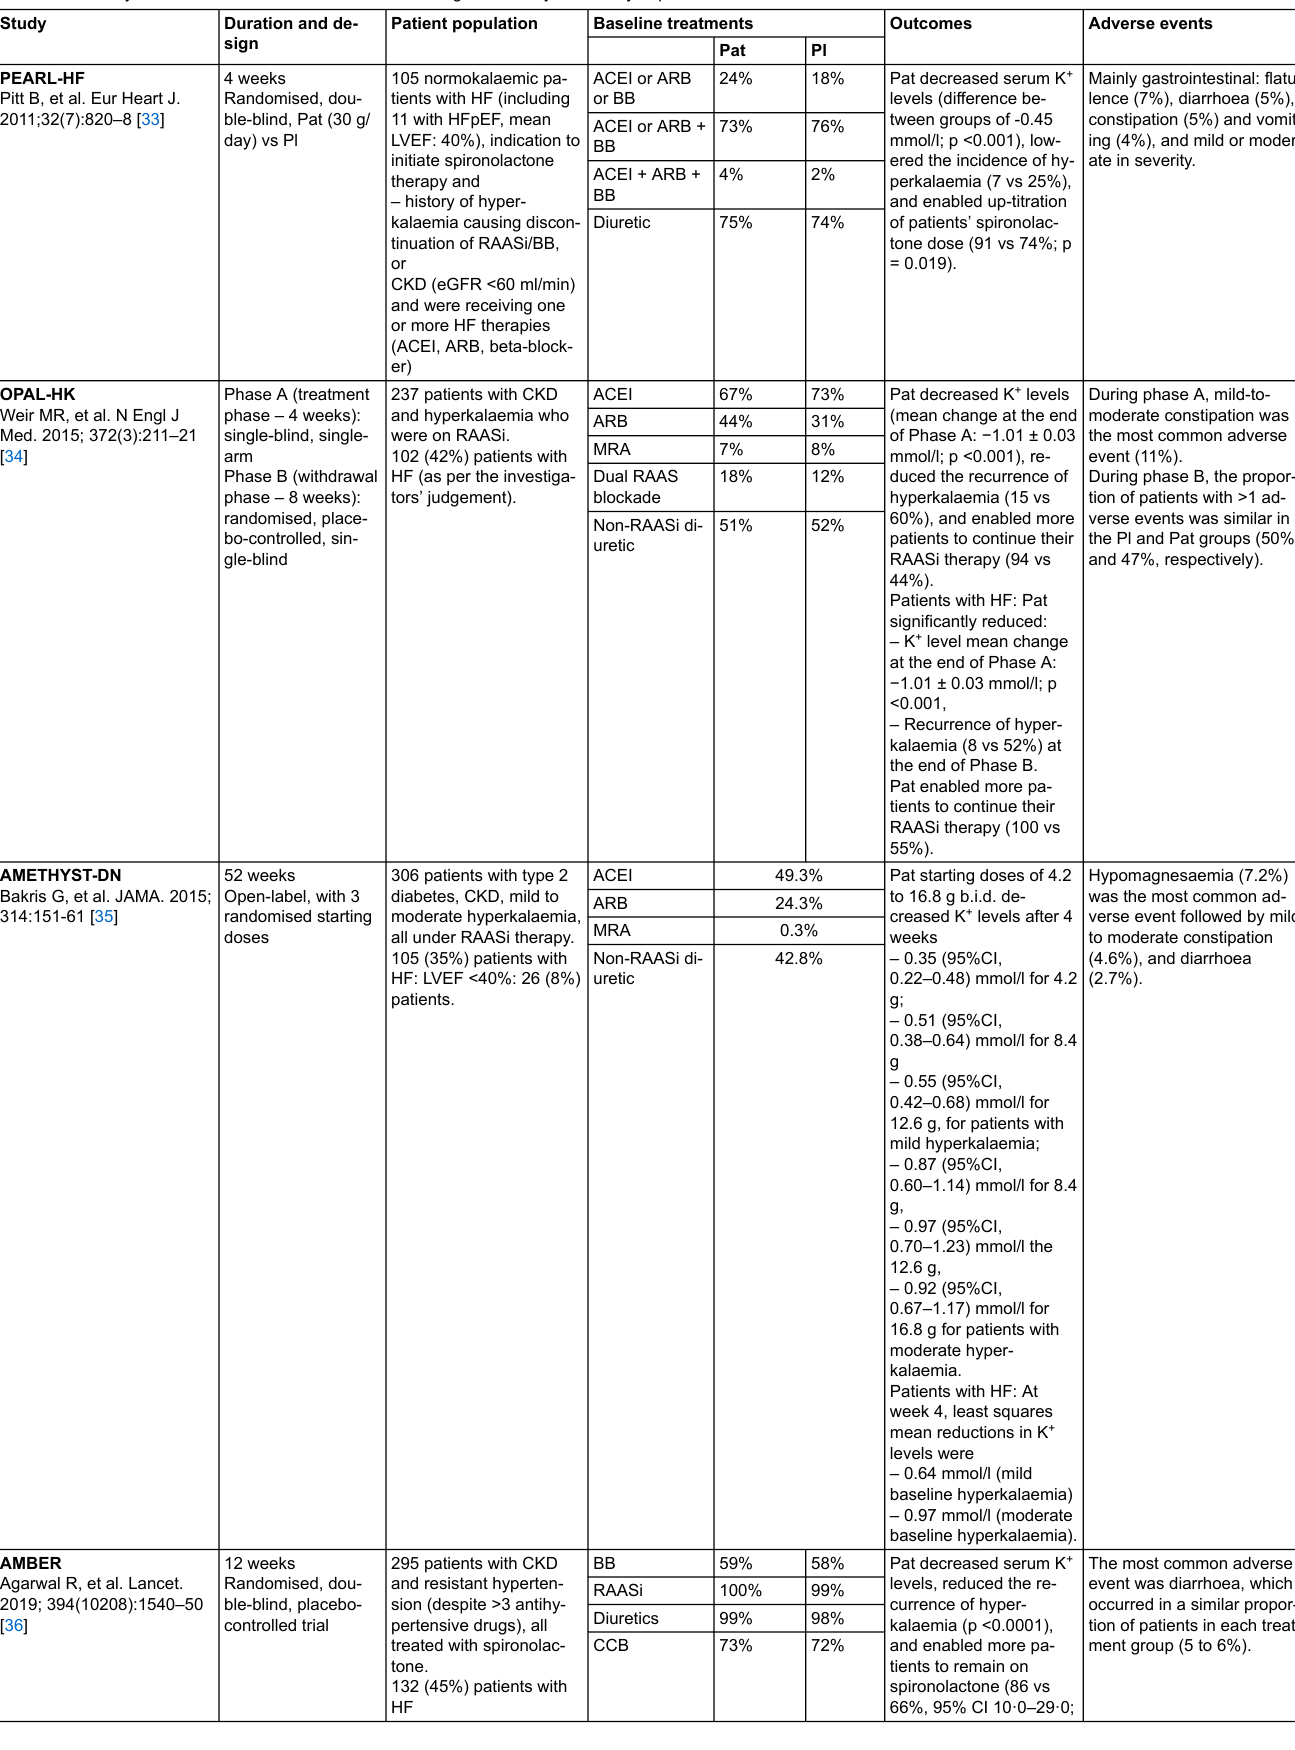
Table 1: Summary of the four main clinical trials demonstrating the efficacy and safety of